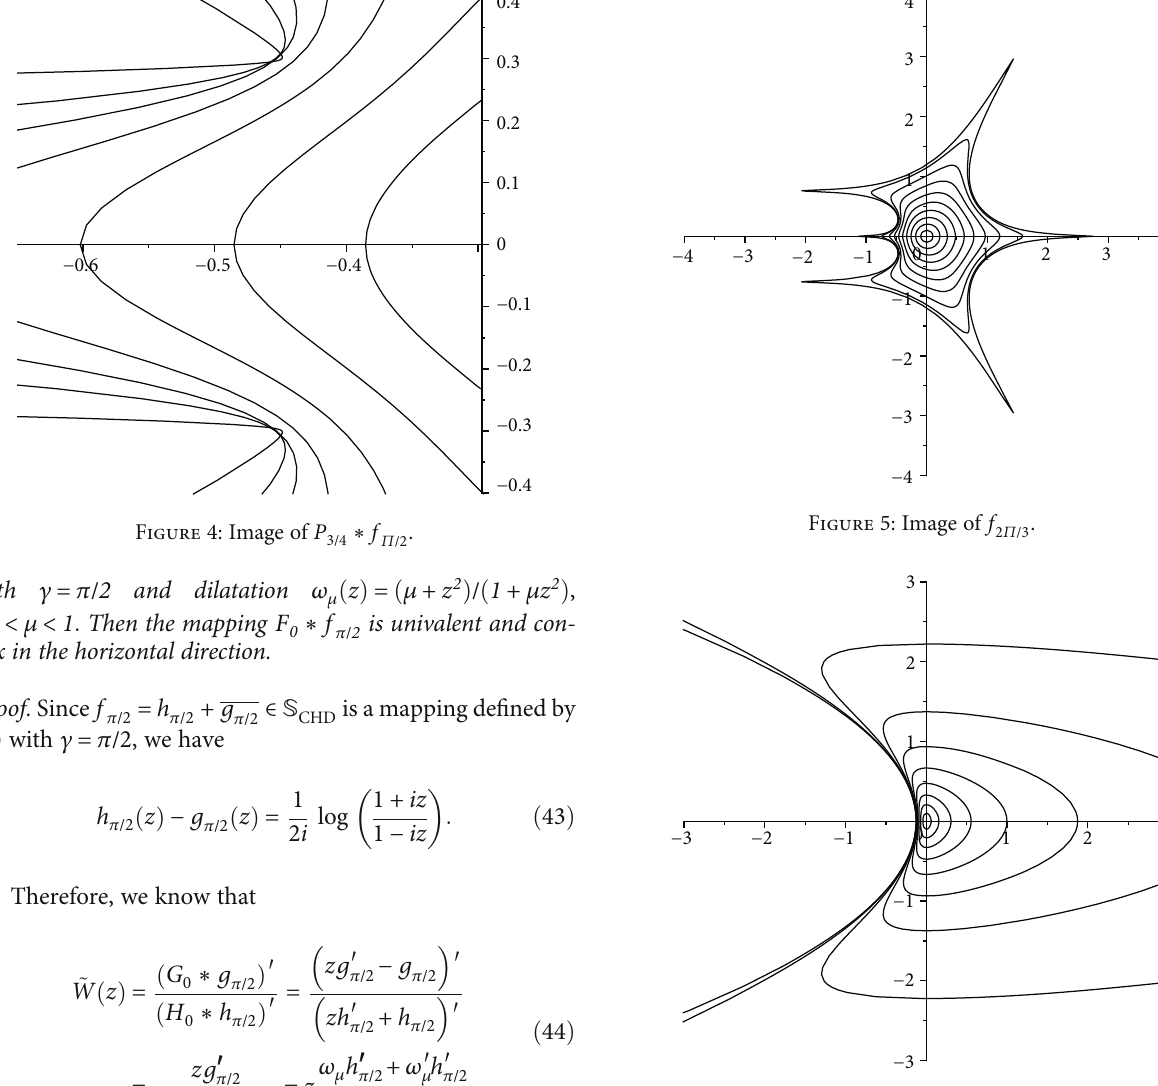
Figure 6: Image of F